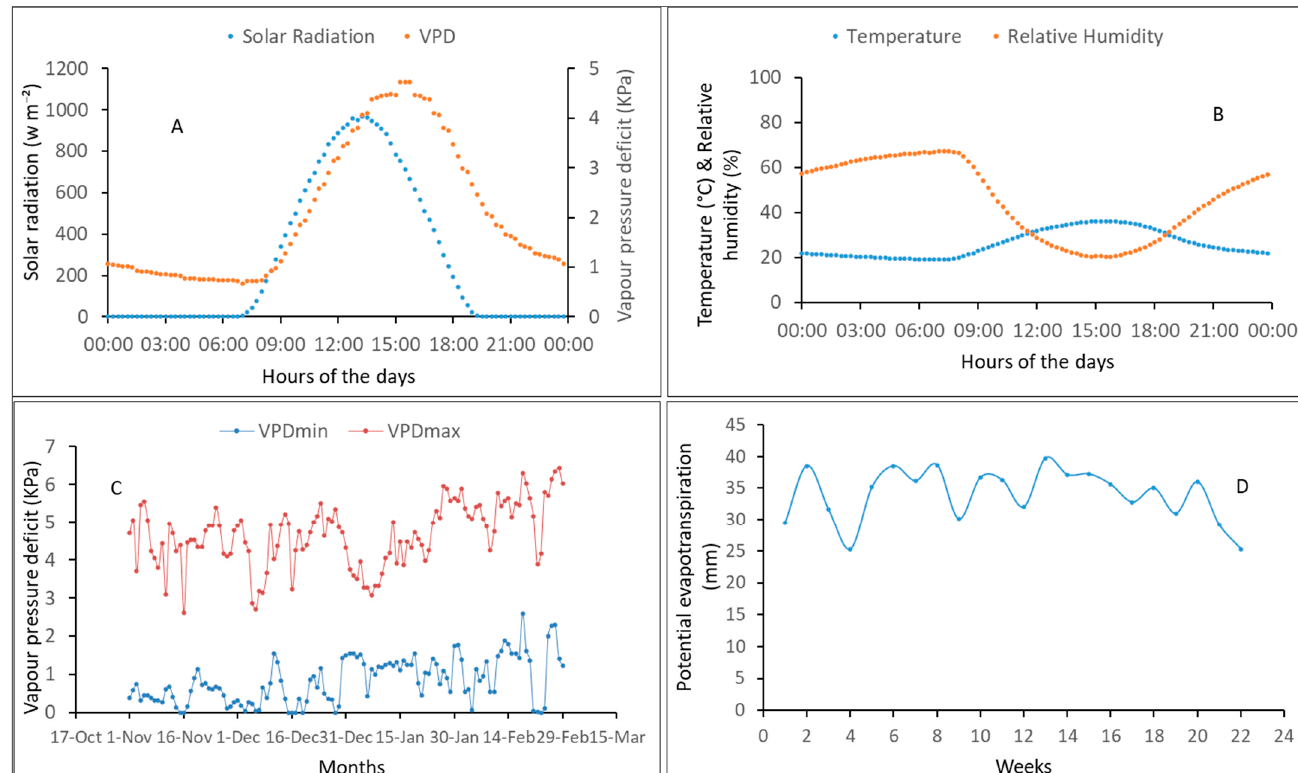
Figure 1. Daily averages of vapor pressure deficit and solar radiation ( A ), temperature and relative humidity ( B ) recorded during the dry season 2018; the minimum and maximum vapor pressure deficit ( C ) and potential evapotranspiration ( D ) recorded during the experiment in 2019.